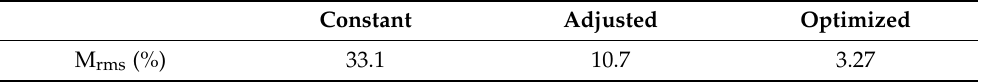
Figure 19. AIG nozzle flow-rate for the random profile (unit, m/s). ( a ) Constant injection; ( b ) adjusted injection; ( c ) optimized injection. Table 5. RMS of NH 3 /NO molar ratio at the inlet of the catalyst layer for the random profile.